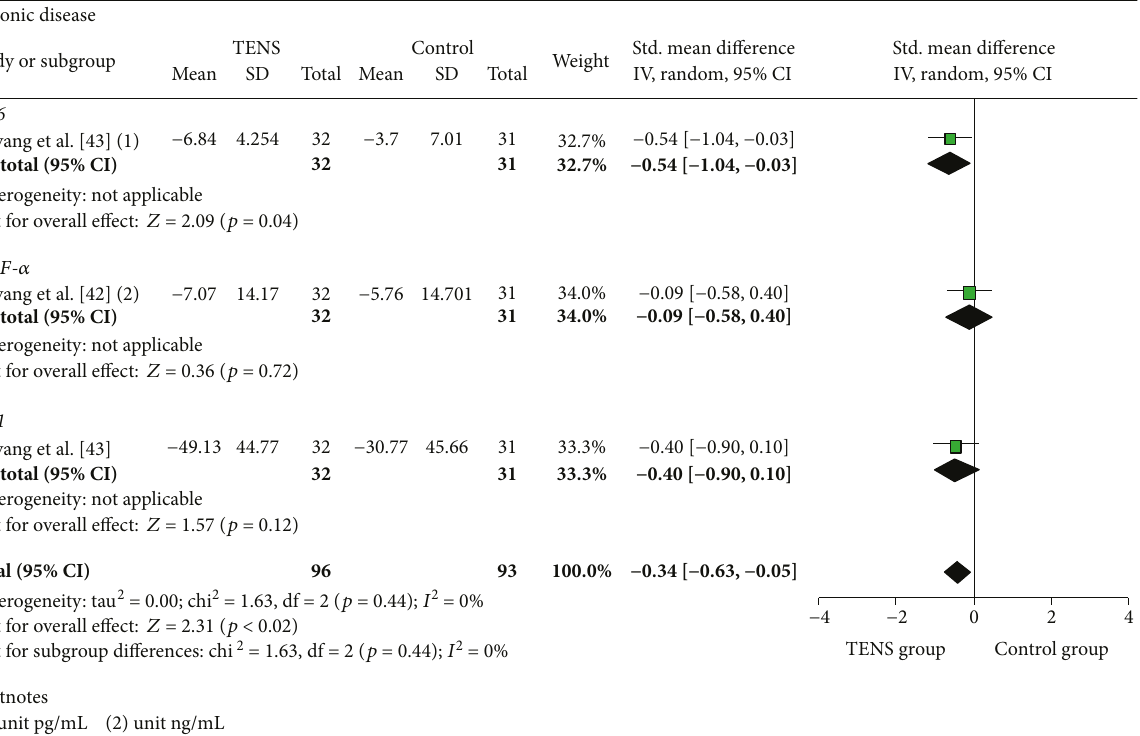
Figure 6: Meta-analysis subgroup chronic